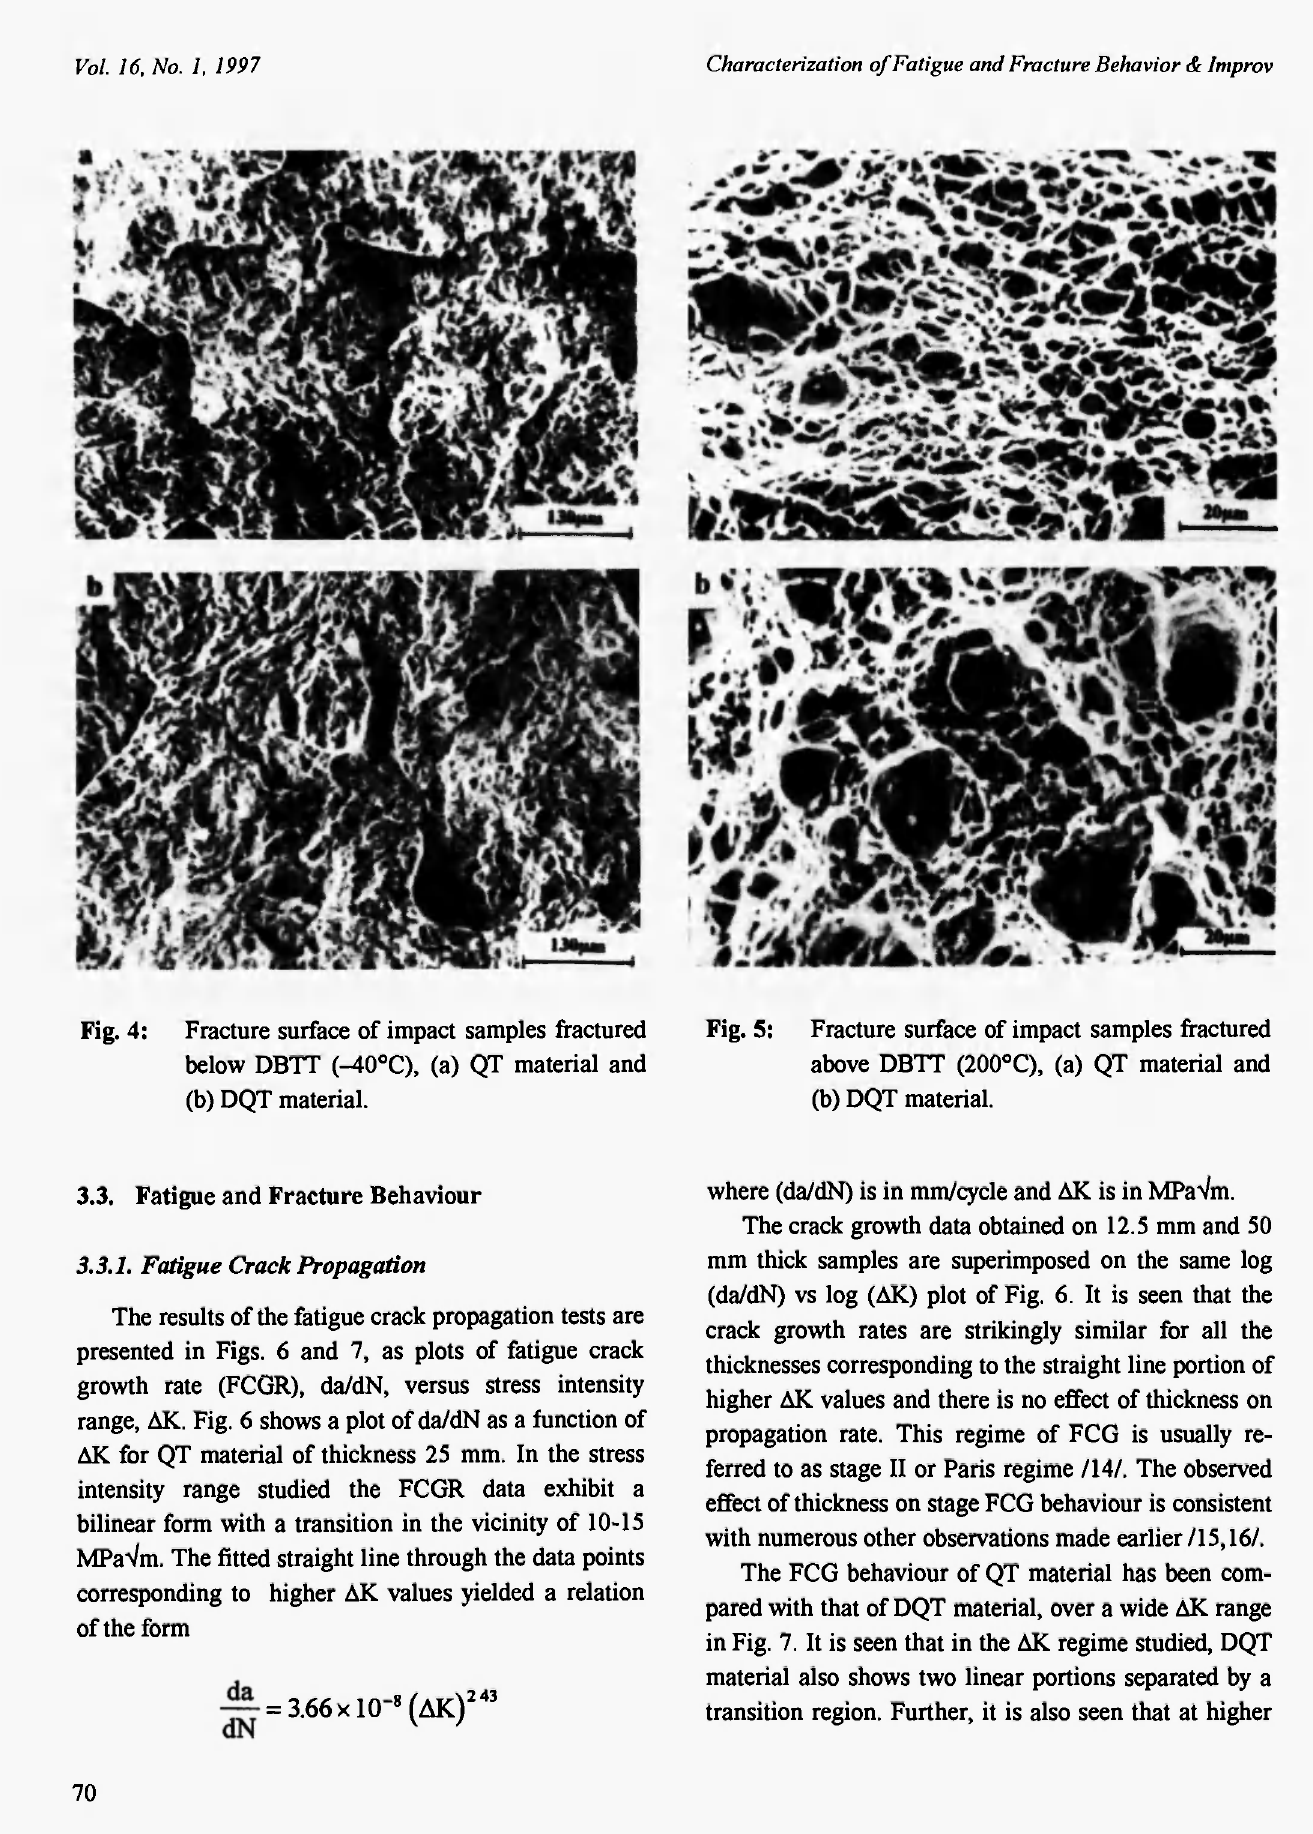
Fig. 5: Fracture surface of impact samples fractured above DBTT (200°C), (a) QT material and (b) DQT